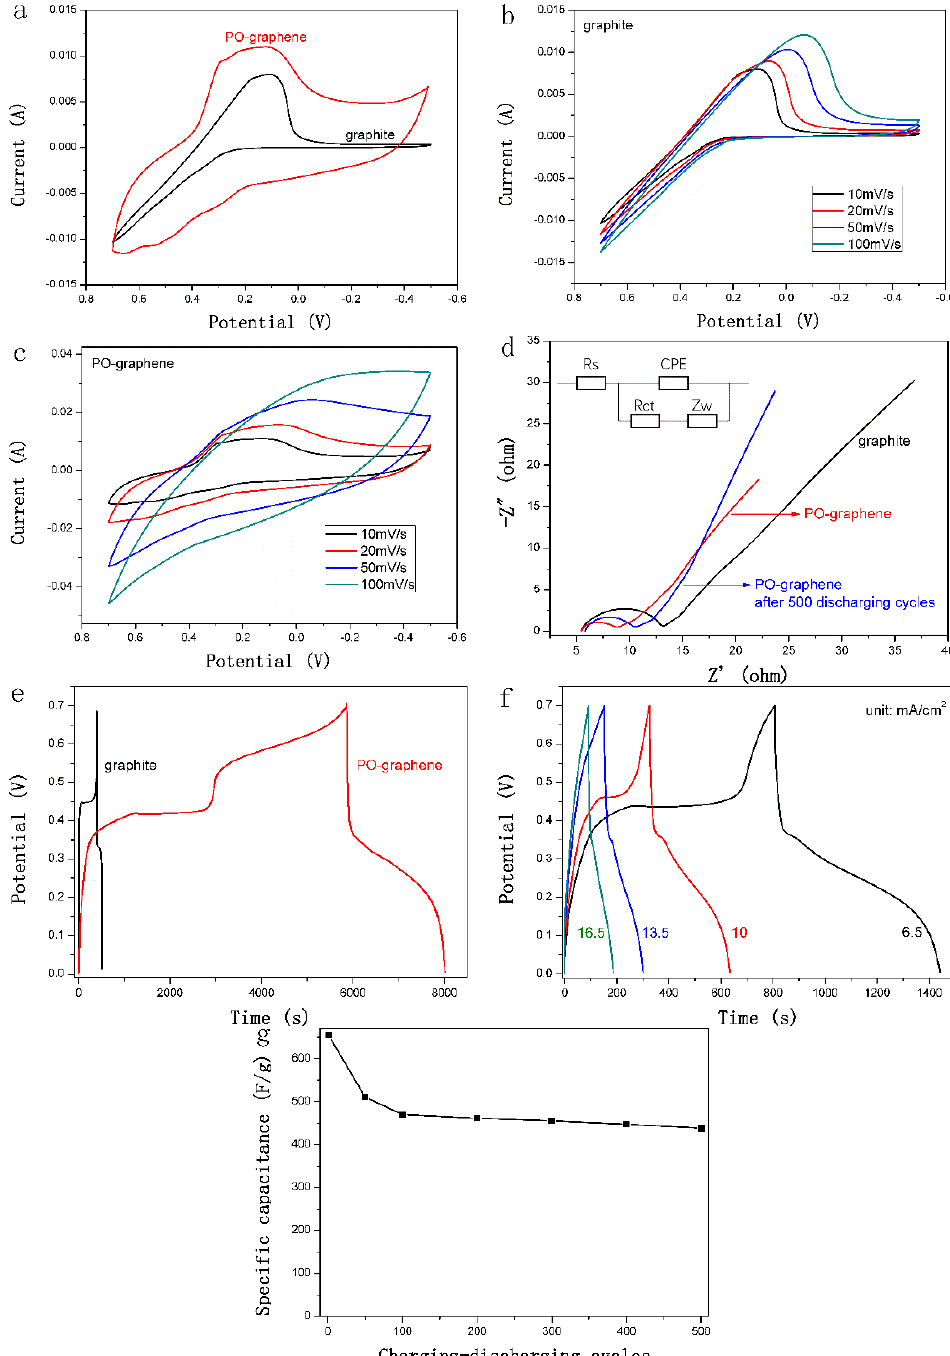
Figure 3. ( a ) Cyclic voltammetry (CV) profiles of PO-graphene and graphite performed in a mixture of 0.1 M KI and 0.2 M H 2 SO 4 aqueous at 10 mV/s; ( b ) CV profiles of PO-graphene and ( c ) graphite at different scan rate; ( d ) Nyquist plots and equivalent circuit (inset) of PO-graphene and graphite; ( e ) galvanostatic charge–discharge (GCD) analysis of PO-graphene and graphite at 3.5 mA/cm 2 ; and ( f ) GCD analysis of PO-graphene at different current density; ( g ) cycling stability analysis at 10 mA/cm 2 .